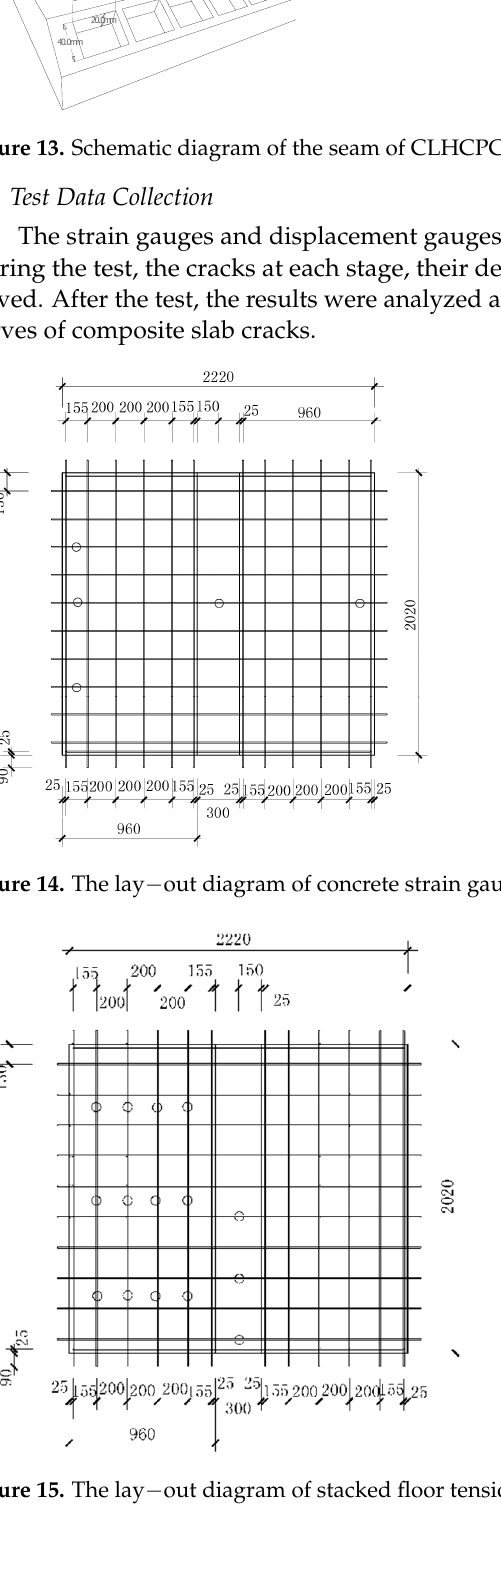
Figure 12. Side op view of seam position of CLHCPCS.